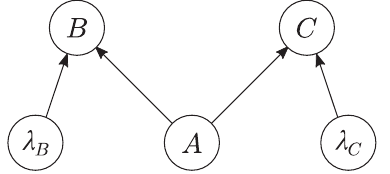
FIG. 4. The causal structure of Fig. 3, expanded so that B and C each have a latent system as a causal parent in addition to A . By analogy to the classical case, we take B and C to depend unitarily on λ B , A , and λ C